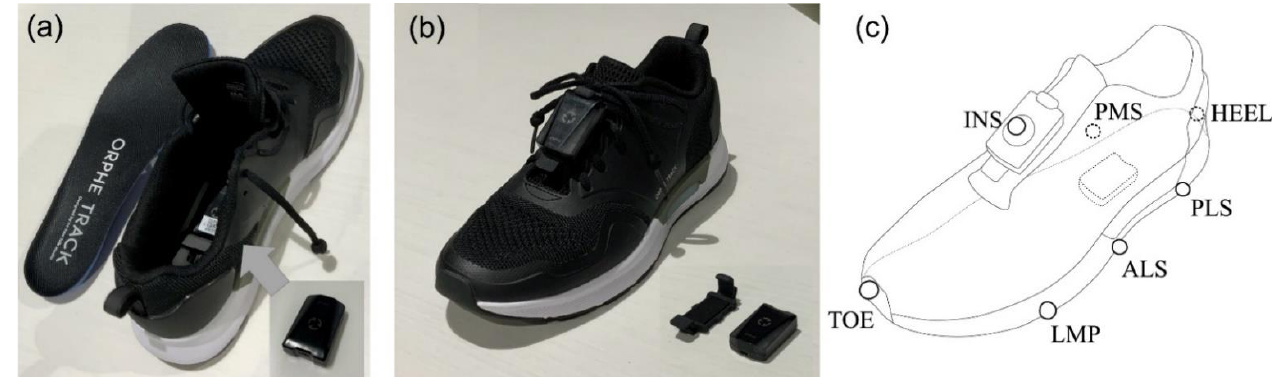
Figure 1. ( a ) Motion sensor embedded in the shoe midsole; ( b ) Motion sensor mounted on the shoe instep with dedicated mounting equipment; ( c ) Marker position on the shoe. ( a ) The shoe has space for sensor placement, and the center of the sensor is located 40% of the shoe’s length from the heel edge. ( b ) A motion sensor mounted on the shoe instep using dedicated mounting equipment that can be fixed to the shoe- lace. ( c ) The names and position definitions of the reflective markers are as follows: LMP, the lateral edge of the metatarsophalangeal joint; TOE, the most anterior edge of the shoe; PLS, the posterior lateral side of motion sensor; ALS, the anterior lateral side of motion sensor; PMS, the posterior medial side of motion sensor; HEEL, the most posterior edge of the shoe midsole; INS, the center of the sensor mounted on the instep equipment of the shoe.